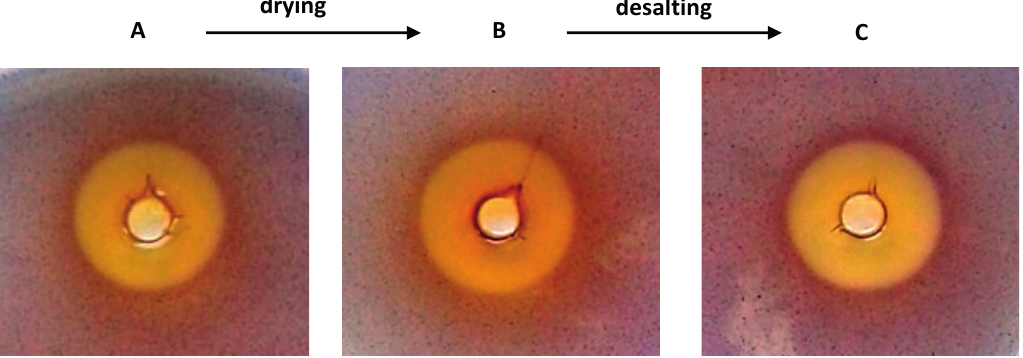
Figure 1. Comparison of antibacterial and anti-QS properties in the “A”, “B” and “C” samples derived from Quercus cortex evaluated with a semi-quantitative agar-diffusion